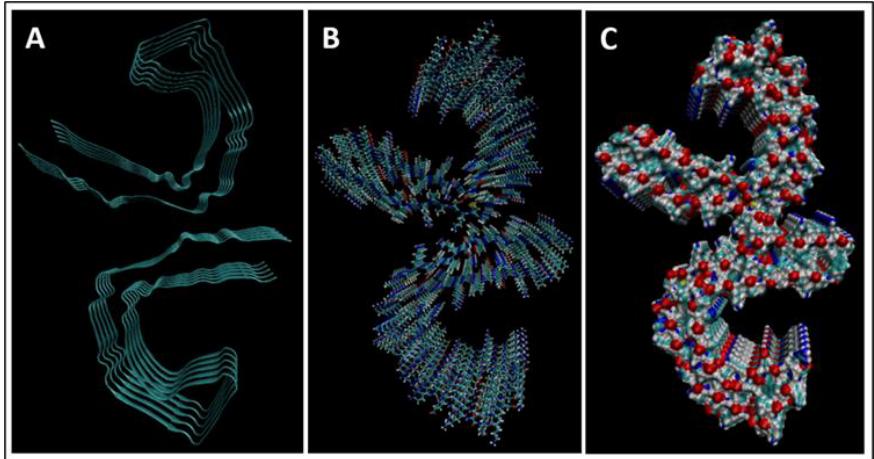
Figure 21. ( A ) A cartoon model, ( B ) a bonds model, and ( C ) a surface model of SF tau.